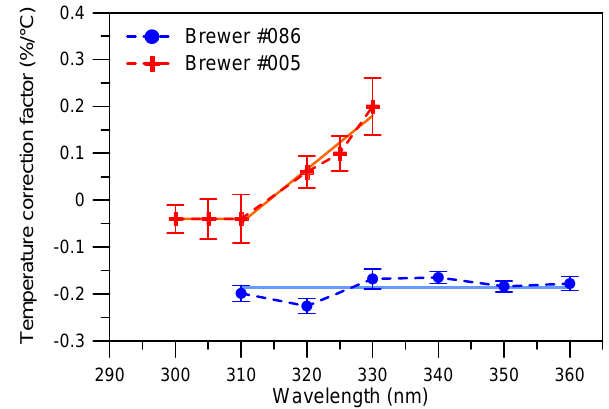
Fig. 6. Wavelength dependence of temperature correction factors for the two Brewer spectroradiometers, #005 and #086, derived from linear fits on lamp irradiance measurements conducted in the laboratory in December